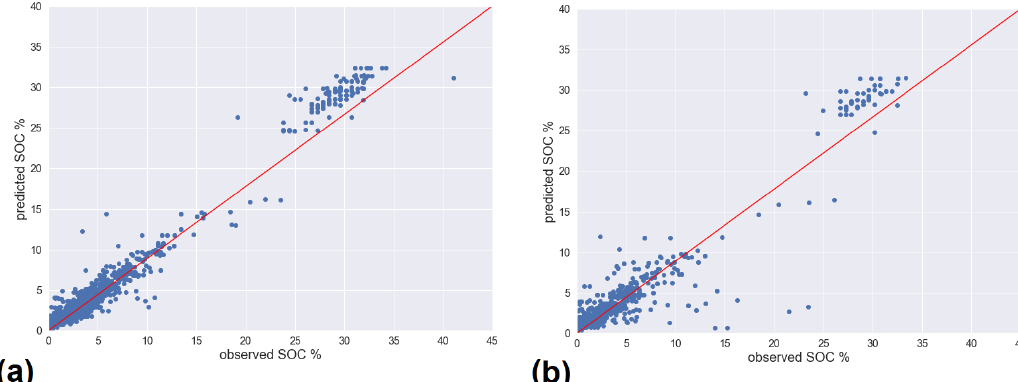
Figure 4. Random forest model cross-validation scatterplot of observed vs. predicted SOC values for the test–validation sample splits: (a) training subsample and (b) validation